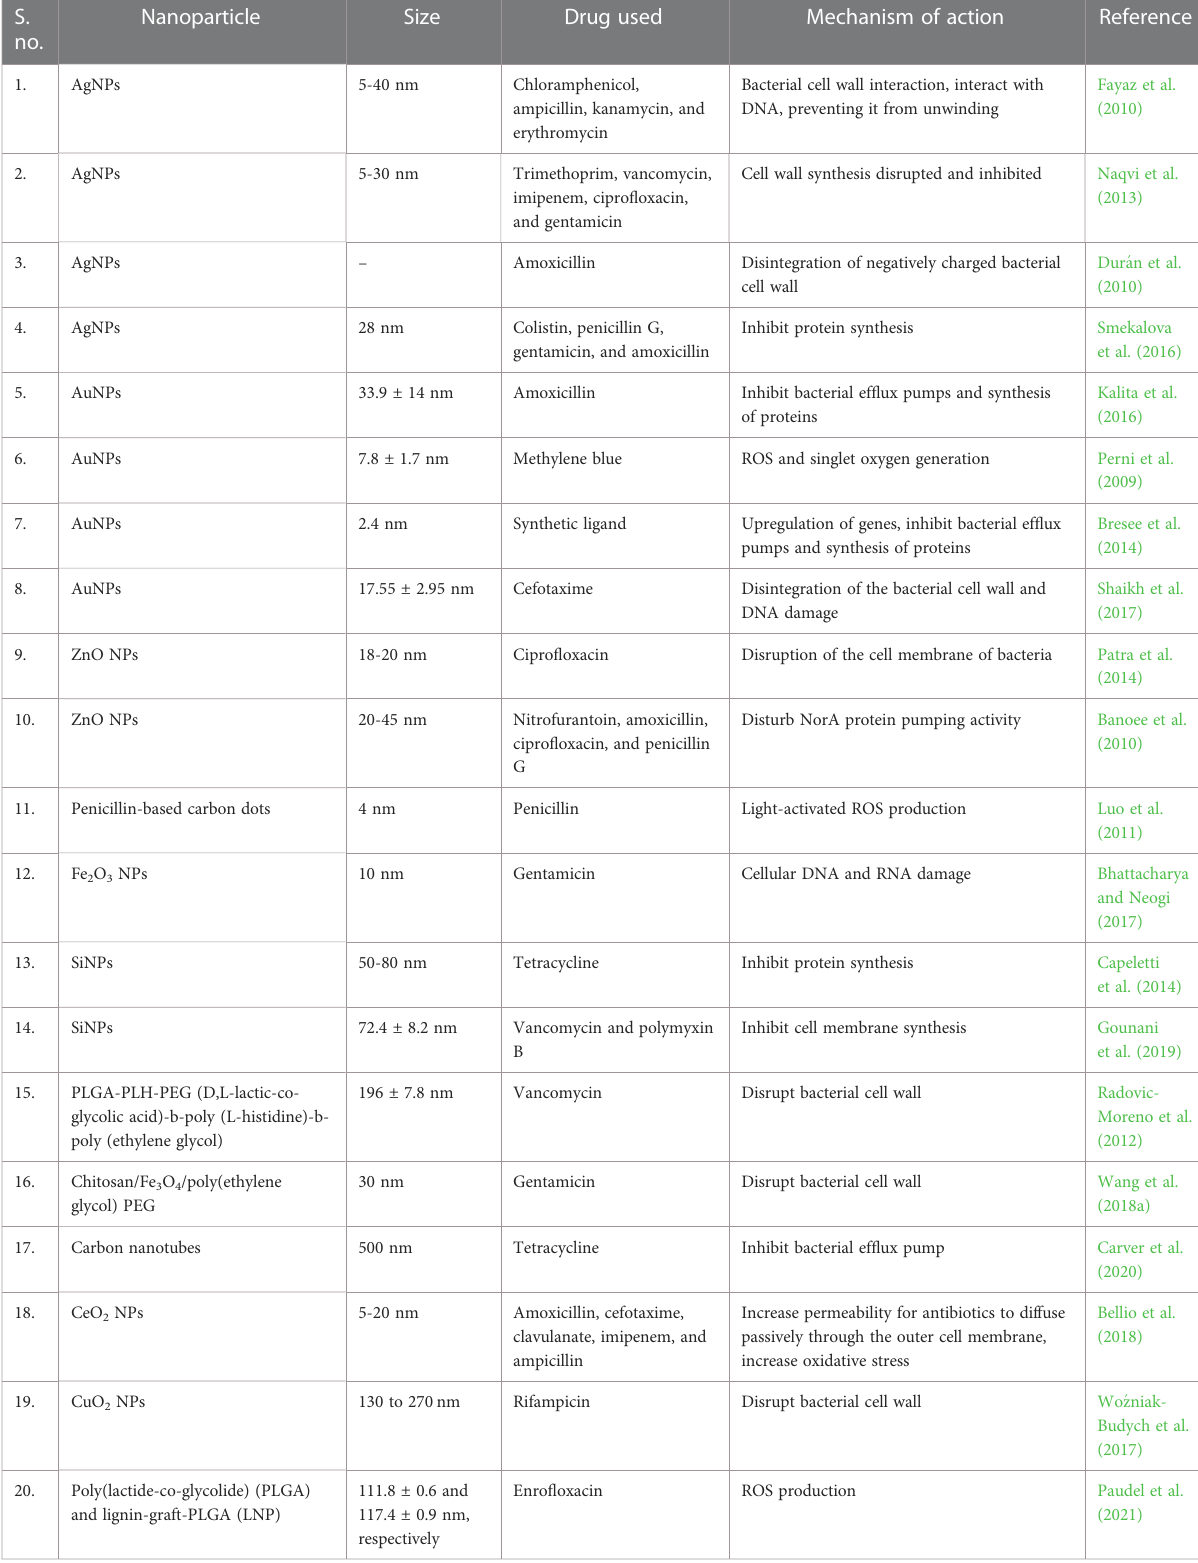
TABLE 5 Various antibiotic – NP conjugates used for Escherichia coli mitigation.